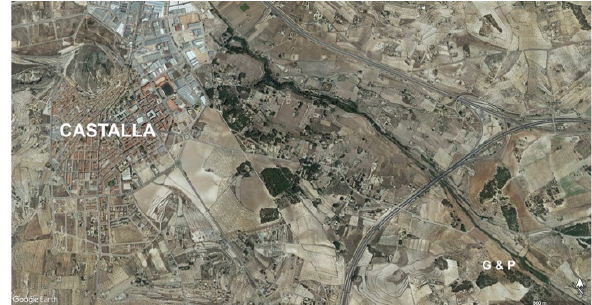
Figure 5. Location of the municipality of Castalla, Casa de la Glorieta (G) and Mas de la Parrotja (P) near the river